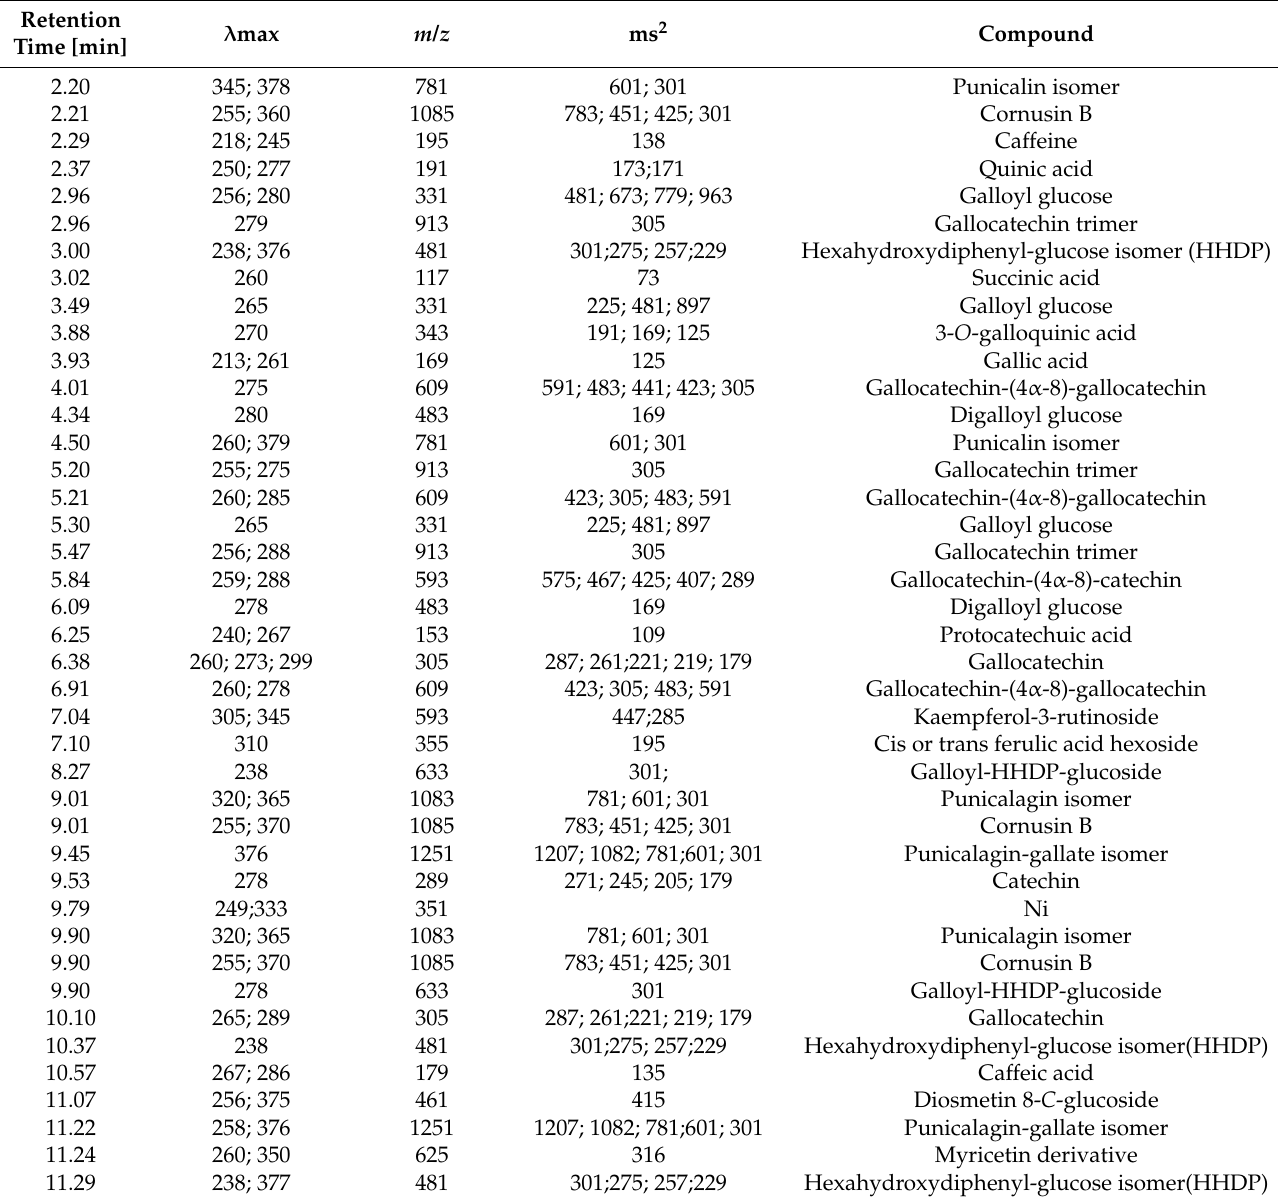
Table 3. Polyphenols in aqueous extract of C. incanus identified using the MS